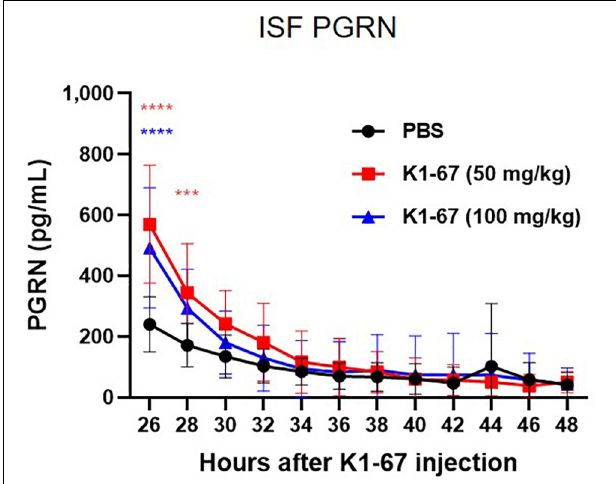
FIGURE 4 | ISF PGRN levels in response to K1-67. Mouse ISF was collected from a probe in hippocampal microdialysis over 24 h after the treatment of K1-67 at 50 mg/kg or 100 mg/kg, i.v. PGRN levels were determined by ELISA. The vertical axis indicates PGRN concentration. The horizontal axis indicates the hours after K1-67 injection. Data are mean ± SD from 10 independent experiments. *** p < 0.001, **** p < 0.0001 vs. PBS by Two-way RM ANOVA analysis with Sidak’s multiple